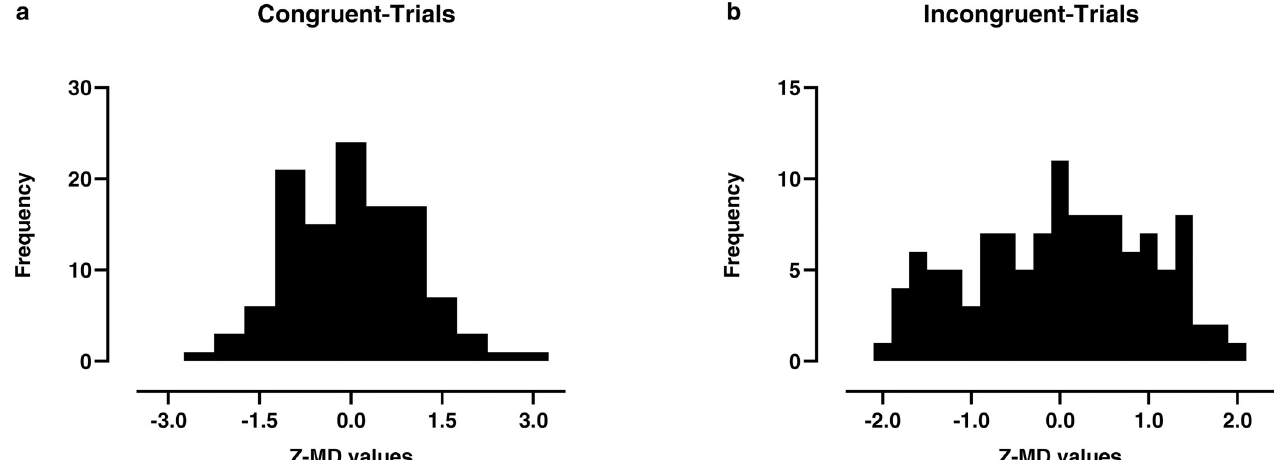
Fig 4. Z-score-transformed MD frequency distributions in stereotype-congruent ( a ) and incongruent ( b ) trials.